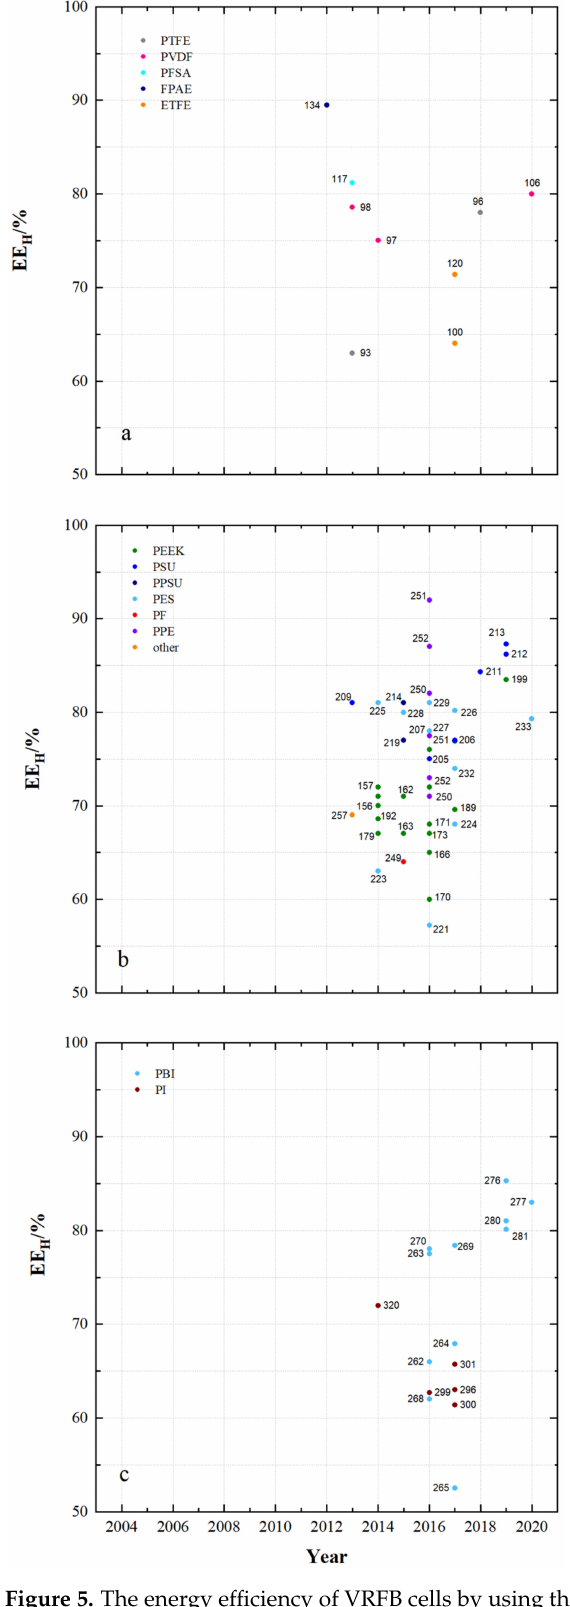
Figure 5. The energy efficiency of VRFB cells by using the developed membrane sample at current densities ≥ 100 mA cm − 2 in recent years: ( a ) fluoro-carbons, ( b ) hydro-carbons and ( c ) N